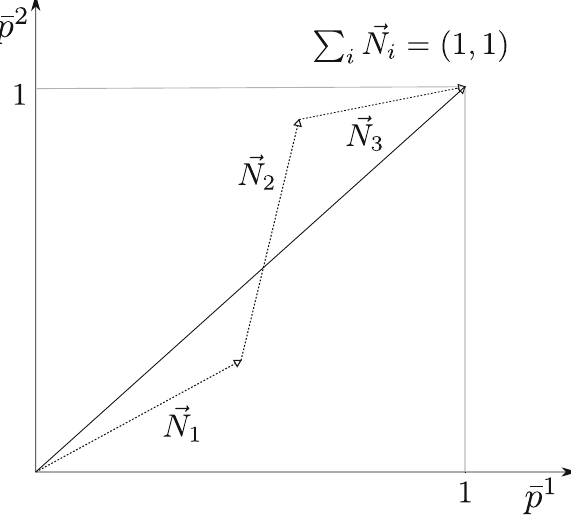
Fig. 1 Illustration of a two-dimensional parameter space and the nor- malized slope vectors that sum up to reach the all-one position of a hyper-cube. Projections of the individual vectors help to split up the parameter space and to assign weights to the sub-tunes